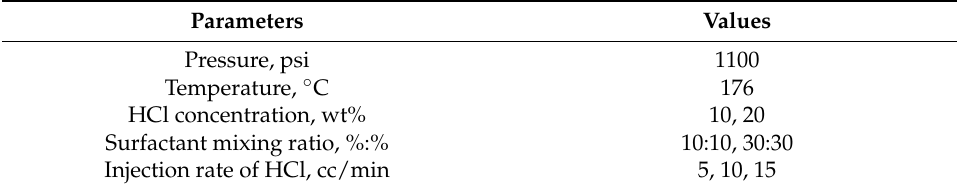
Table 3. Experimental conditions for foam stability analysis. Parameters Values Pressure, psi 1100 Temperature, ◦ C 176 Surfactant mixing ratio, %:% Injection rate of HCl,